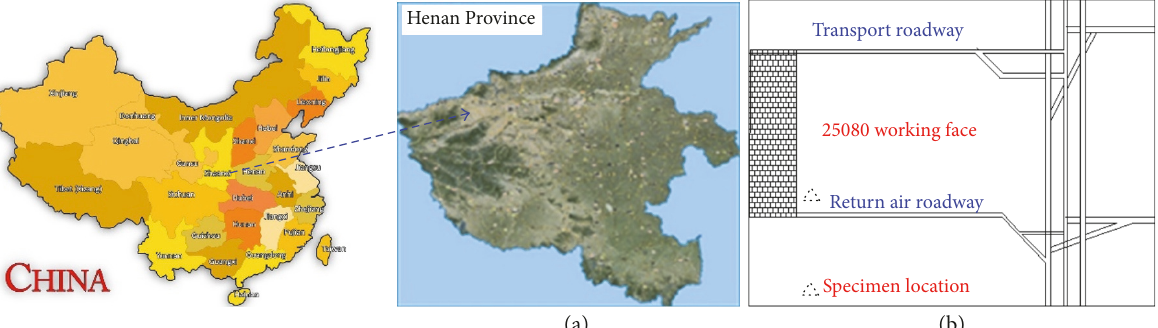
Figure 2: Location of Yuejin coal mine: (a) Yuejin coal mine in Henan province, China, and (b) selected specimen locations in 25080 working face.